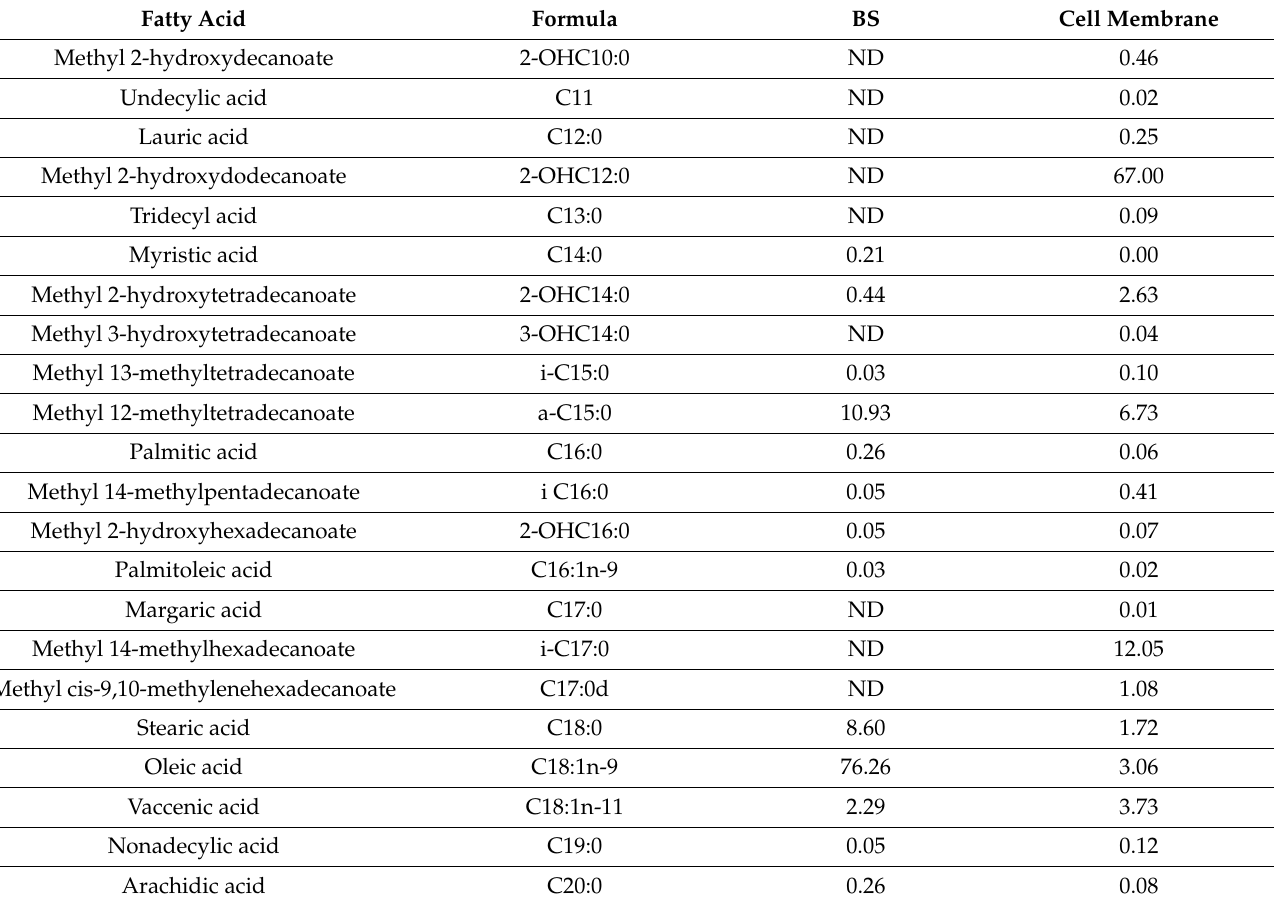
Table 2. Fatty acid composition of the cell membrane of Pantoea alhagi and the secreted biosurfac- tants